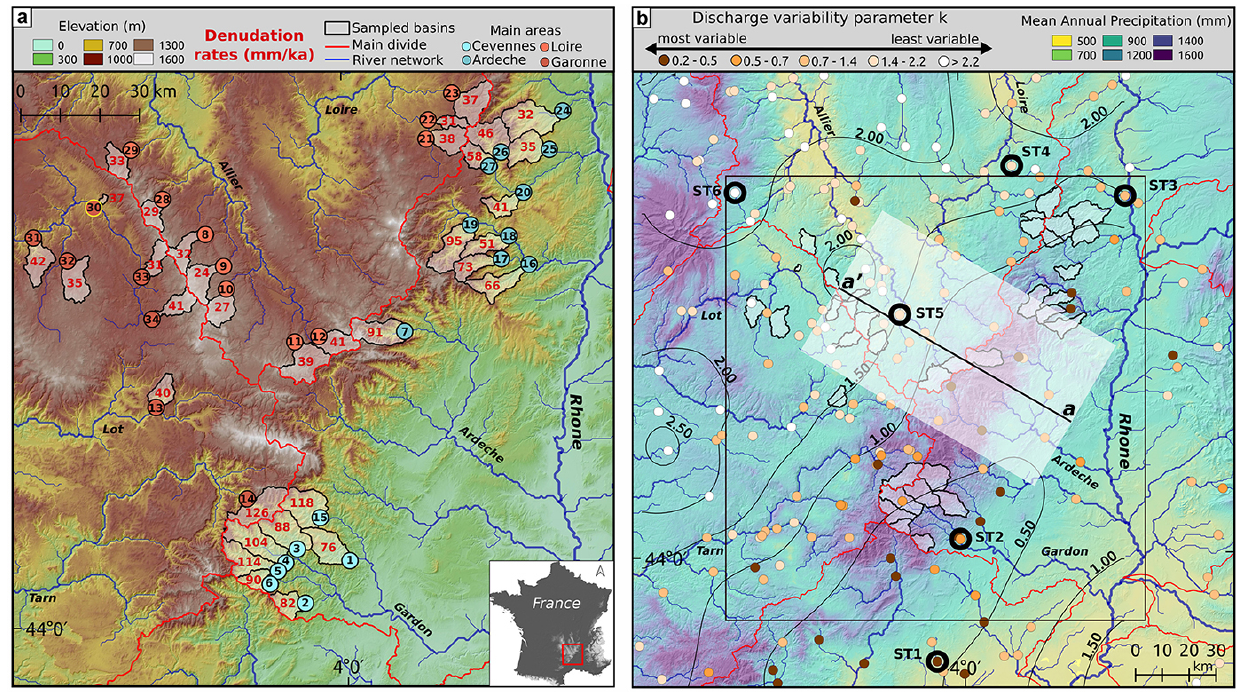
Figure 1. (a) Topographic map of the southeastern margin of the Massif Central (France), with the location of the sampled basins and their denudation rate (red numbers). Black numbers identify the different samples. The red lines are the main regional drainage divides between the majors catchments: Loire (Lo), Rhône (Rh), and Garonne (Gr). For basins in the Rhône catchment, we distinguish two areas corresponding to the Cévennes (Rh-C) and Ardèche (Rh-A) mountains (Table S3). (b) Distribution of precipitation over the studied area. The black rectangle indicates the extent of (a) . Colored circles are the gauging stations where the discharge variability coefficient k was estimated, with dark contours indicating selected stations with discharge distributions presented in Fig. 3. Dark contours correspond to a thin plate spline surface fitted to the variability data. aa’ indicates the position and lateral extent of the swath profile presented in Fig.